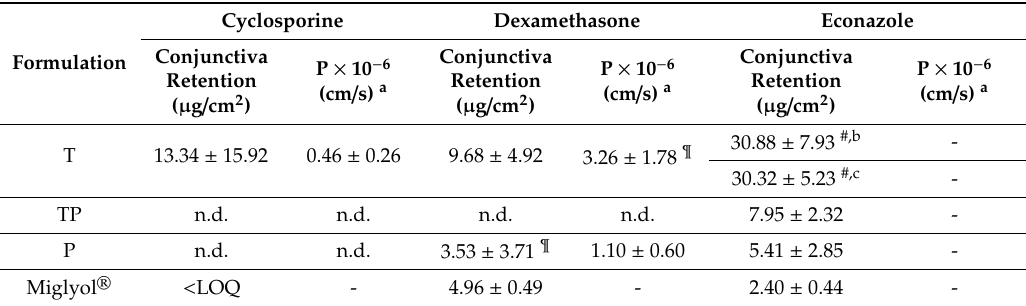
Table 5. Apparent permeability coe ffi cient (cm / s) and drug retention in the conjunctiva after 5 h of contact with micelles and the Miglyol ® solution /